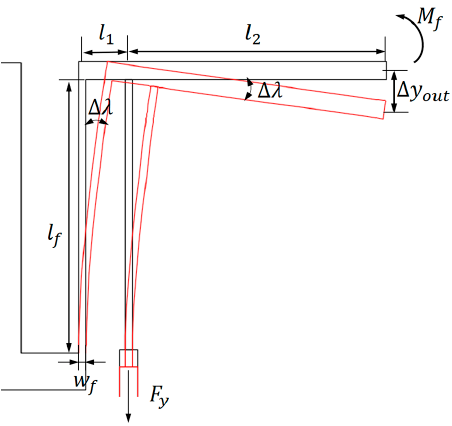
Figure 9. The micro lever for the displacement magnification.